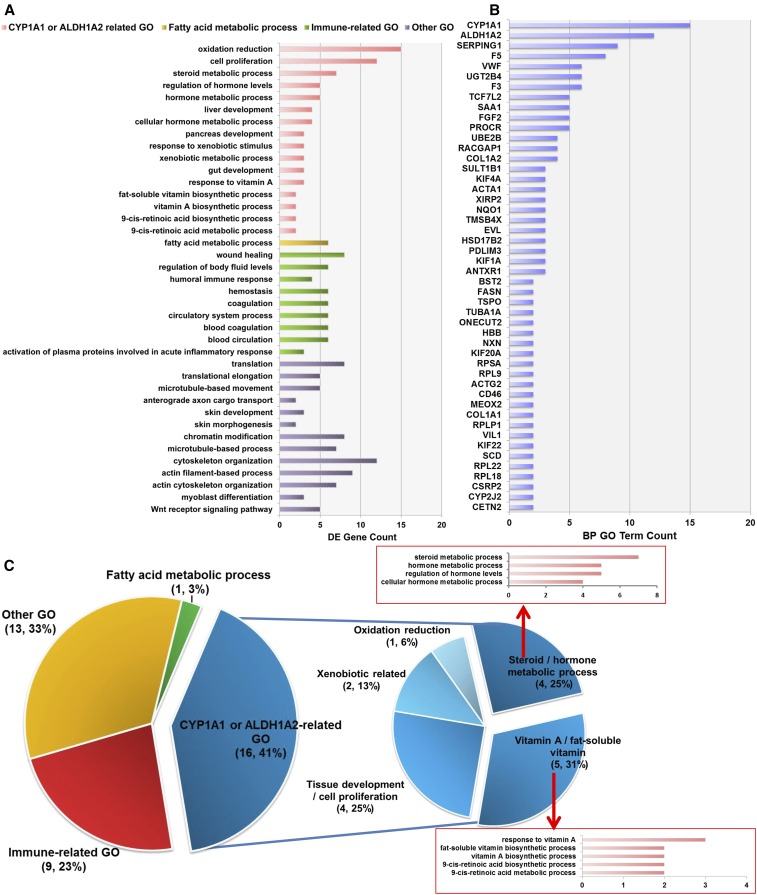
Significantly enriched GO terms for biological processes. (A) Significantly enriched biological process GO terms. The significant GO terms were determined by DAVID Bioinformatics Resources 6.7 (EASE Score < 0.1). Pink, orange, green, and purple colors represented the CYP1A1- or ALDH1A2-related, fatty acid metabolic process, immune-related, and other GO terms, respectively. (B) Distribution of DE genes in significantly enriched GO terms. Genes involved in at least two GO terms are listed. (C) Statistical analysis of the clustering results of GO terms. The most enriched category was the CYP1A1- or ALDH1A2-related GO terms (41%; left pie plot), which included five vitamin processes and four steroid-/hormone-related processes (right pie plot).